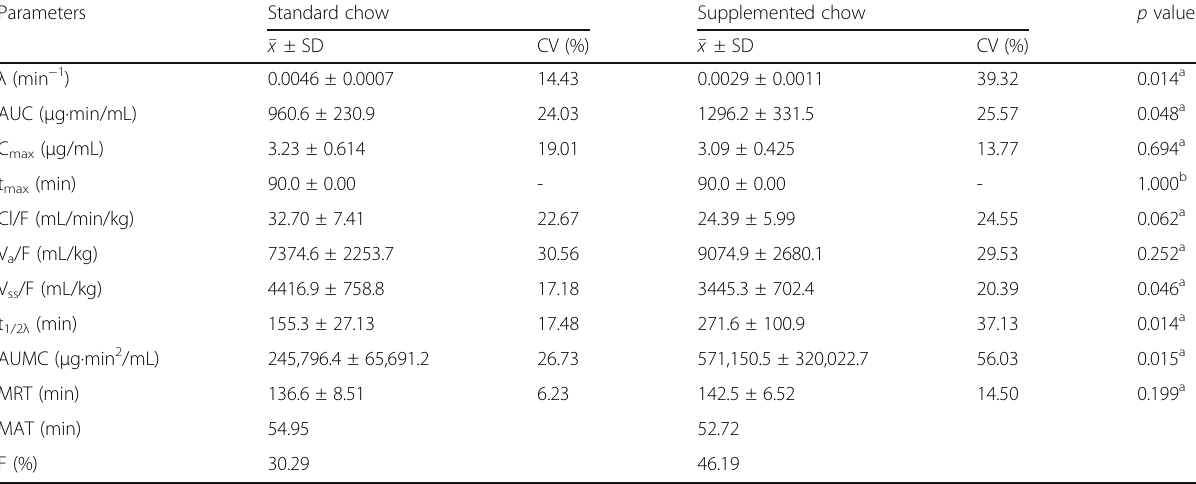
Table 3 Non-compartmental pharmacokinetic parameters obtained for metformin after its oral administration (30 mg/kg) to diabetic rabbits ( n =